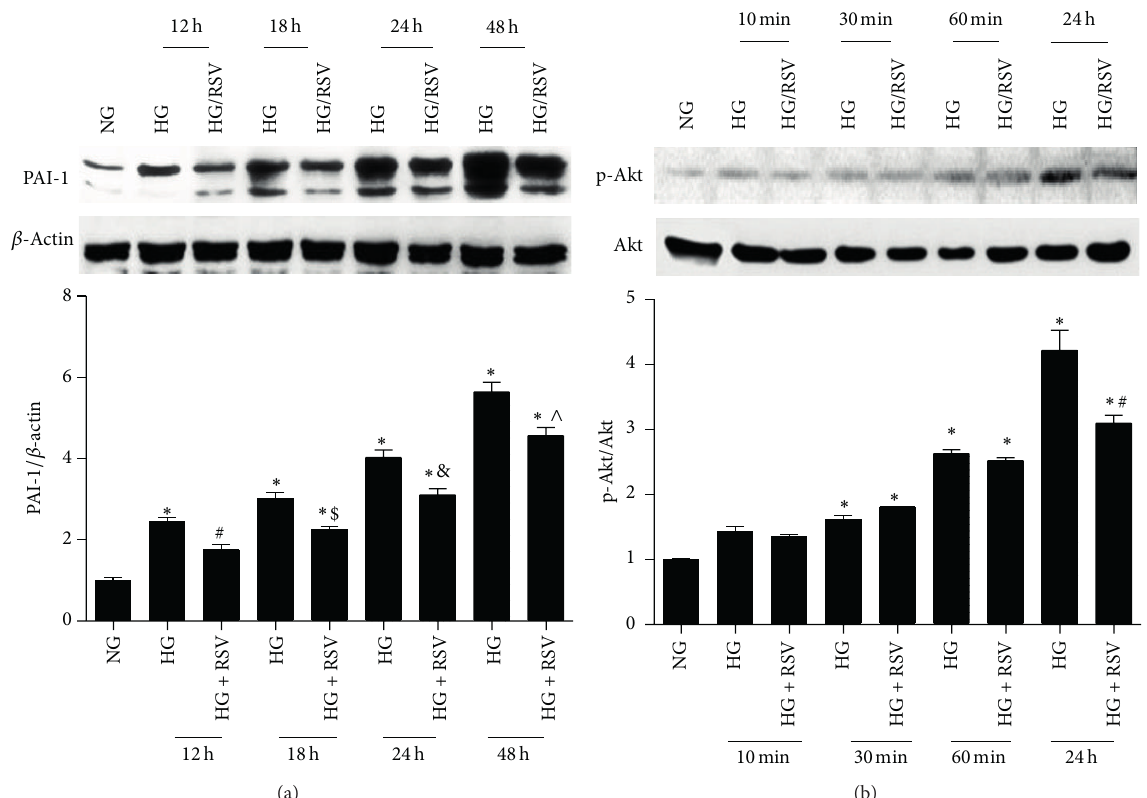
Figure 1: Resveratrol (RSV) attenuated HG-induced PAI-1 expression and Akt activation in rat mesangial cell (RMC). RMCs were cultured in DMEM containing 5.6 mM glucose (NG) or 25 mM glucose (HG) in the absence or presence of RSV (25 𝜇 M) for different periods of time, the protein levels of plasminogen activator inhibitor (PAI-1) (a); Akt and p-Akt (b) were detected using Western blotting assay. Results represent the mean ± SD. ∗ 𝑃 < 0.05 compared with NG, # 𝑃 , $ 𝑃 , & 𝑃 , and ∧ 𝑃 < 0.05 compared with HG in the same time